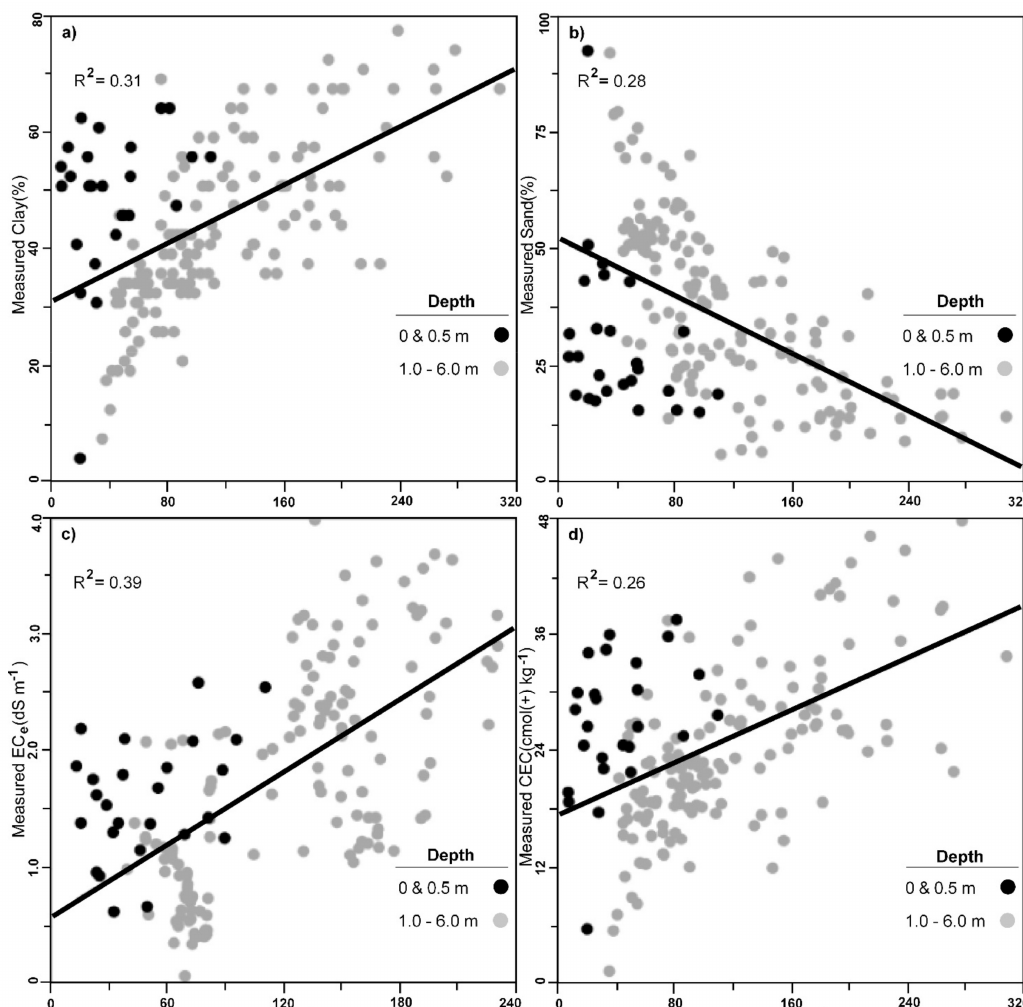
Figure 4. Plots of estimates of the true electrical conductivity ( σ —mS m − 1 ) versus the predicted ( a ) clay (%), ( b ) sand (%), ( c ) electrical conductivity of a saturated soil paste extract (EC e —dS m − 1 ) and ( d ) cation exchange capacity (CEC—cmol( + ) kg − 1